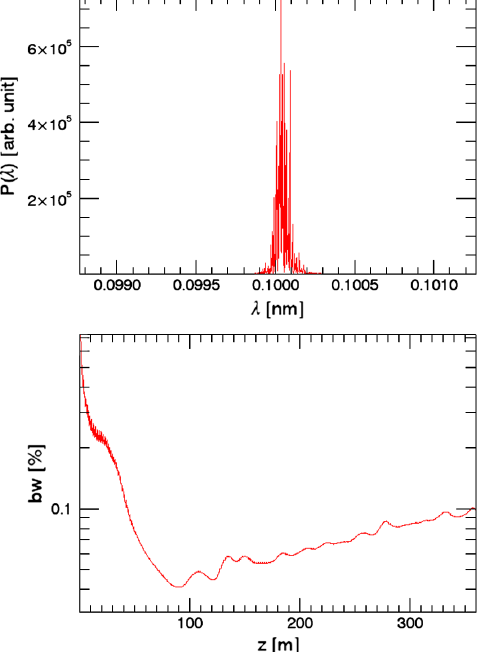
FIG. 12. Radiation spectrum shows peak at desired hard x-ray wavelength of 1 A˚ (top) and bandwidth drops to 4 (cid:4) 10 (cid:1) 4 rms at 100 m